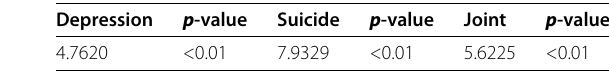
Table 6 Model improvement through inclusion of Google